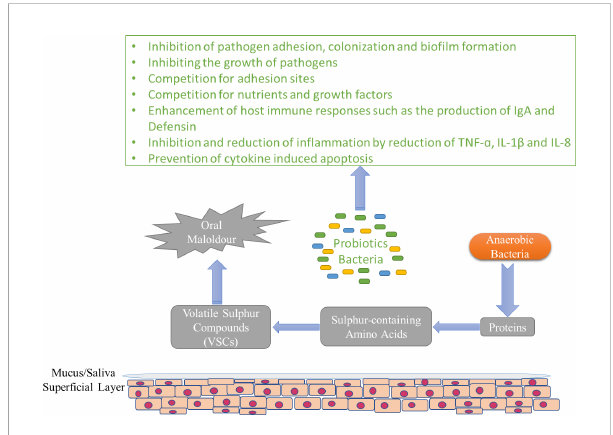
FIGURE 3 The general pattern of formation of VSCs and possible mechanisms of probiotics in the prevention of